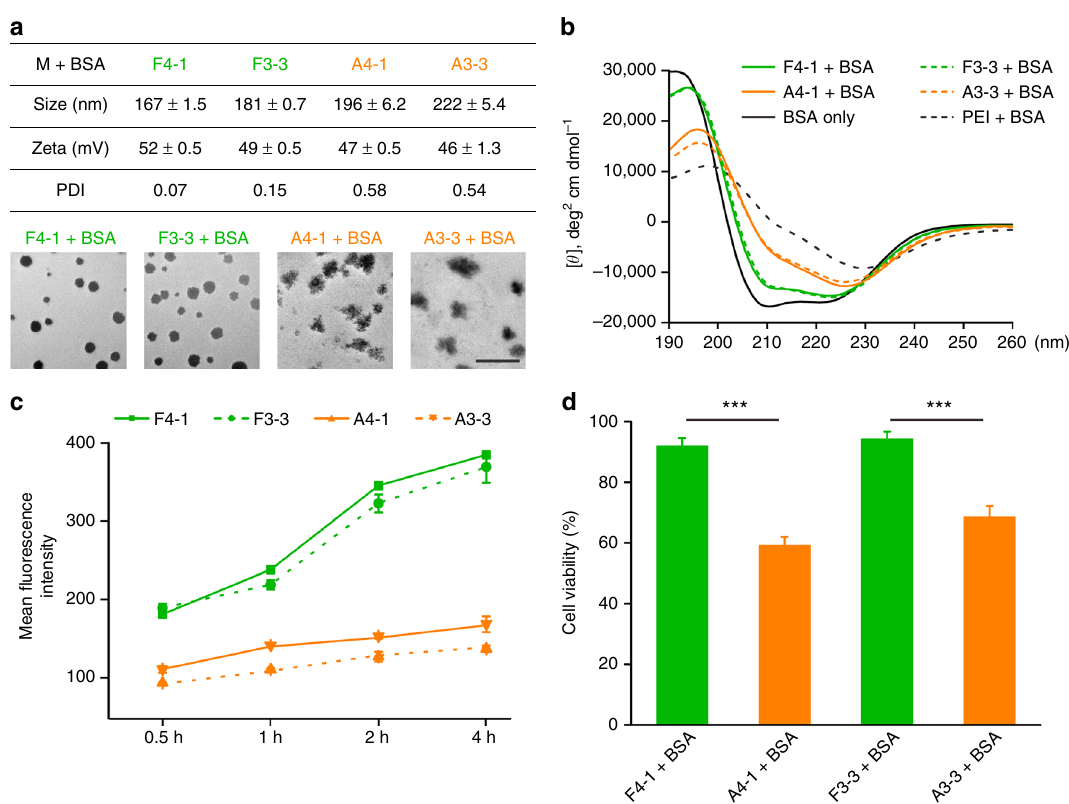
Fig. 3 Mechanisms of fl uoroamphiphiles. a Size, zeta-potential, PDI, and TEM images of nanocomplexes. Data are presented as mean ± s.d. ( n = 3). A representative result from three independent experiments. The scale bar is 500 nm. b Circular dichroism spectra of nanocomplexes. BSA concentration in b is 3 μ M, and the polymer/protein molar ratio in a , b is 1:1. c Cellular uptake of FITC-labeled polymers in the absence of proteins. The polymer concentration is 5 μ g/mL. Data are presented as mean ± s.e.m. ( n = 3). d The viability of HeLa cells treated with different nanocomplexes. The BSA concentration is 0.3 μ M. Data are presented as mean ± s.e.m. ( n = 5). *** p < 0.001 analyzed by Student ’ s t -test, one